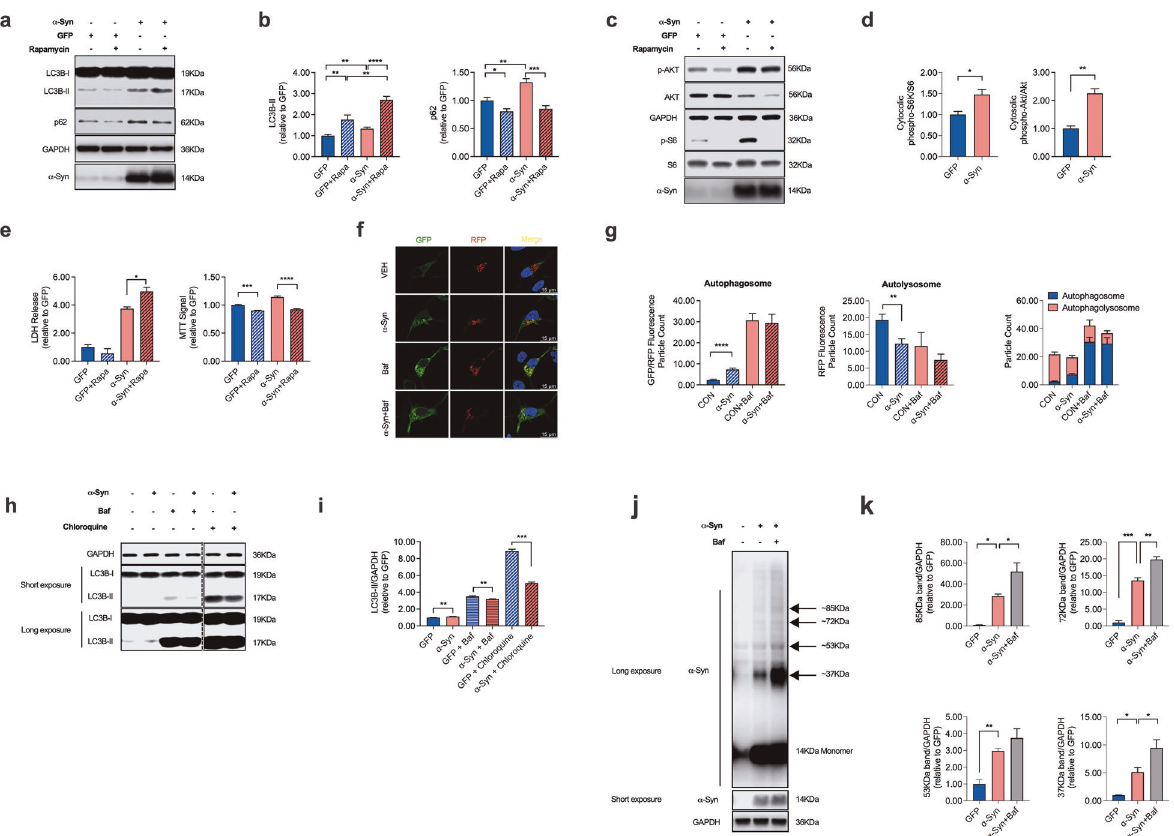
Fig. 1 α -Syn overexpression attenuates autophagy turnover. a , b Western blot and bar graphs illustrating the abundance of sequestome-1/ p62 and LC3B-I and -II in response to α -Syn overexpression and in response to treatment with rapamycin (100 nM; 24 h; n = 10/condition). c , d Western blot and bar graphs illustrating the abundance and phosphorylation of mTOR associated signaling molecules (Akt; S6) in response to α -Syn overexpression and in response to treatment with rapamycin (100 nM; 24 h; n = 3/condition). e Bar graphs illustrating the quanti fi cation of LDH in the culture medium (left) and the MTT signal (right) in response to α -Syn overexpression or to treatment with rapamycin (100 nM; 24 h; n = 4/condition). f Photomicrographs from confocal microscopy of neurons transduced with GFP-RFP-LC3B and either co-transfected with vehicle (VEH), α -Syn or treated with ba fi lomycin A1 (Baf; 100 nM; 8 h; for VEH n = 25 cells, for α -Syn n = 26 cells, for Baf n = 5 cells, and for Baf + α -Syn n = 5 cells) g Bar graphs illustrating the count of fl uorescence positive particles. α -Syn and Baf both lead to